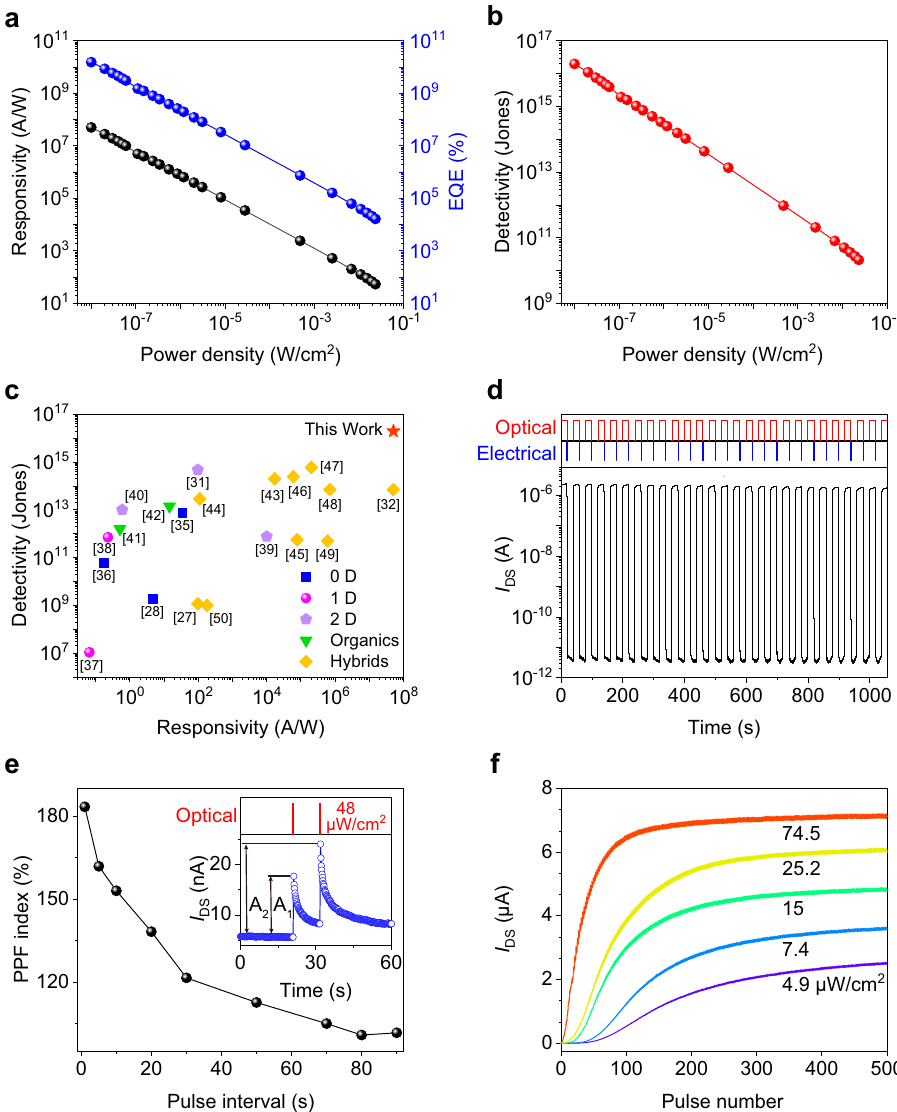
Fig. 2 Optoelectronic and synaptic characteristics. a Dependence of the responsivity ( R ) and the external quantum ef fi ciency (EQE) on the lighting power (cid:1) (cid:3) density ( P ). R ¼ I ph = P L ch ´ W ch , where I ph is the photocurrent , L ch and W ch are, respectively, the channel length (20 μ m) and channel width (100 μ m). EQE ¼ hcR = e λ , where h is the Planck constant, c the speed of light, and e the electron charge. λ = 405 nm. b Dependence of the speci fi c detectivity ( D* ) on (cid:1) (cid:3) (cid:1) (cid:3) 1 = 2 = S 1 = 2 , where S the P . D (cid:2) ¼ R L ch ´ W ch n is the noise power density (Supplementary Fig. 16). c Benchmark of the device performance demonstrating n